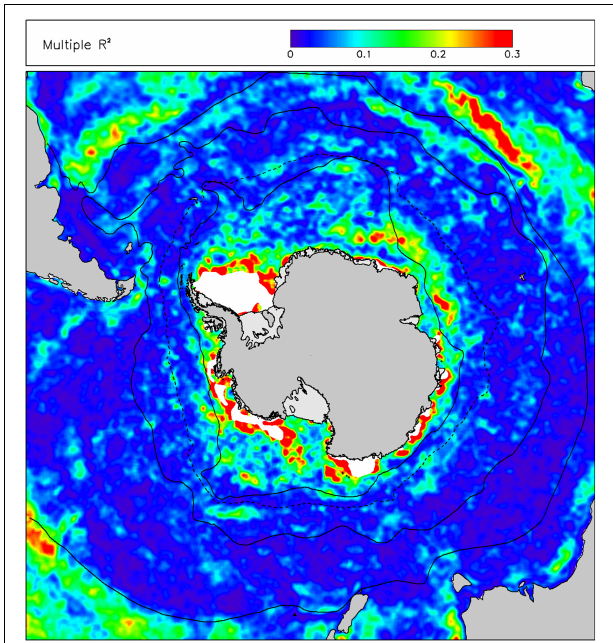
FIGURE 3 | Proportion of variance explained ( R 2 ) in anomalies of chlorophyll-a concentration ( chl ) by a multiple linear regression of anomalies of environmental drivers: sea-surface temperature ( sst ), sea ice concentration ( sea-ice ), mixed layer depth ( mld ) and incident irradiance at the sea-surface ( par ). Other information as Figure 2